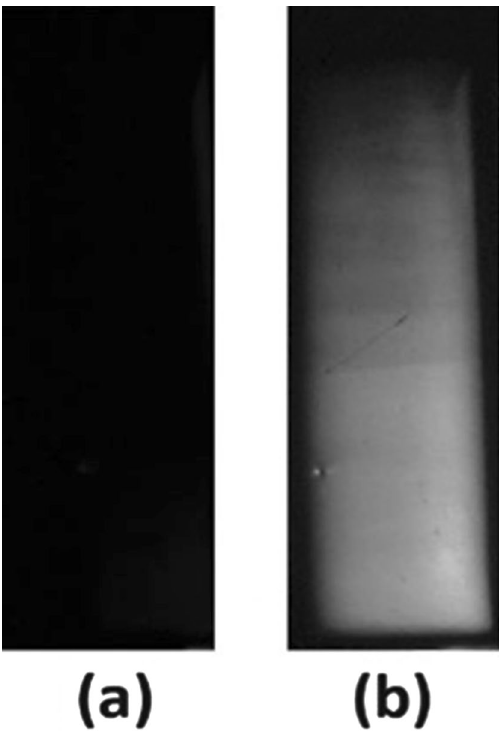
Figure 2. Cross polarized IR transmission images for an as-grown Cd 0.9 Zn 0.1 Te 0.98 Se 0.02 sample: under ( a ) zero bias and ( b ) under the applied bias. Cathode is placed at the bottom surface and the anode on the top surface of the sample.